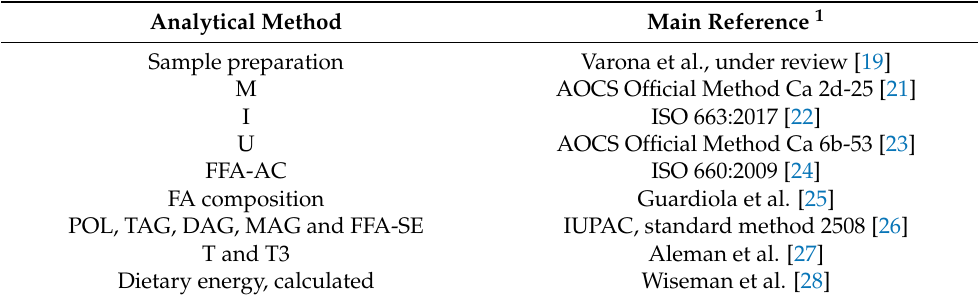
Table 2. Analytical methods used to determine the quality parameters of acid oils and fatty acid